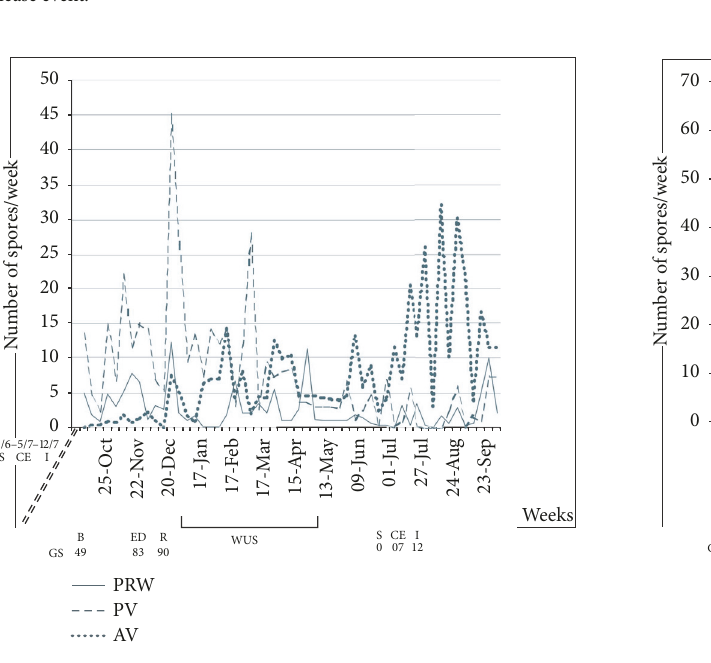
∗ Values were taken 30 days before the occurrence of the release event. ∗∗ mm of rainfall. ∗∗∗ Values were taken 3 and 15 days before the occurrence of the release event.